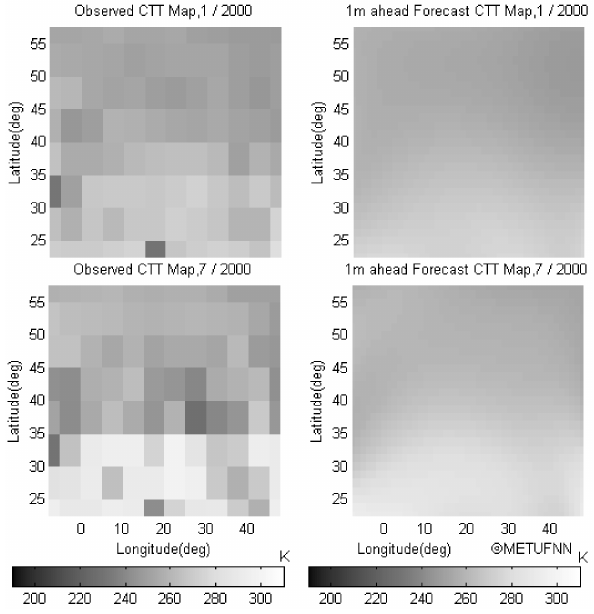
Fig. 4. Observed and 1 month ahead Forecast %CC maps of January and July 2000.